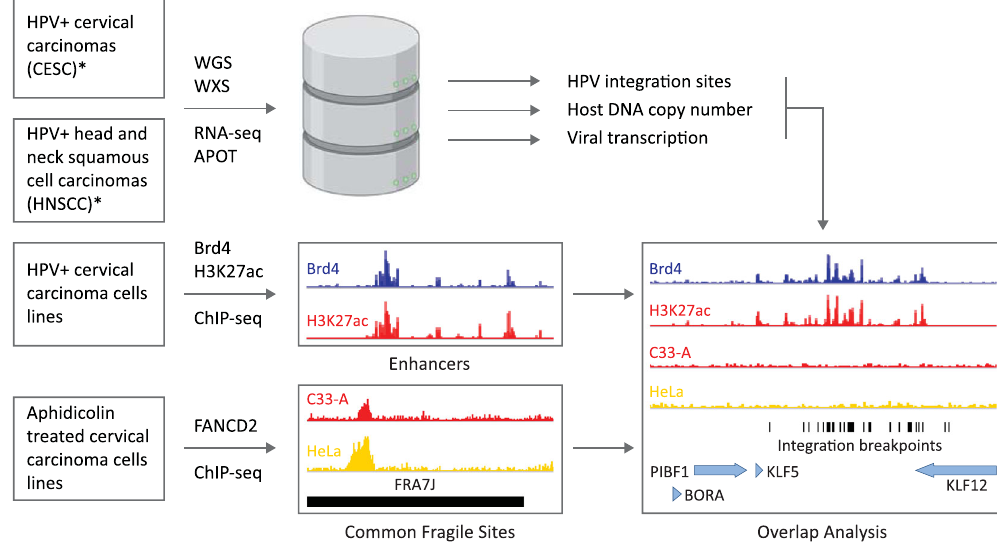
Fig. 1 Overview of datasets. Schematic representation of datasets used for overlap analysis of CESC and HNSCC integration sites with enhancers mapped in W12 cervical keratinocytes and FANCD2-associated common fragile sites mapped in C33-A and HeLa cervical carcinoma cell lines. APOT ampli fi cation of papillomavirus oncogene transcripts, WGS whole genome sequencing, WXS whole exome